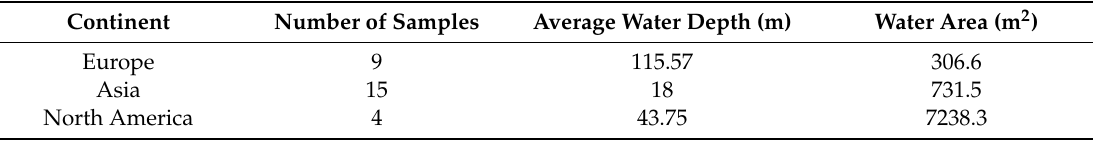
Table 6. The statistical average water depths and water areas of the waterbody